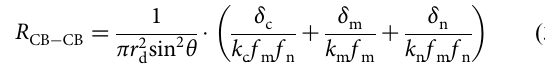
Fig. 5 Melting process of an ice droplet on the MCNP surface. a Schematic illustration of melting process. b Direct observation from the side view. The orange dashed line indicates the melting front. Blue curved arrow represents the inclining direction of the ice droplet. Red arrows indicate the bubble movement directions. Bubbles and air pockets are marked with orange dashed boxes and red dashed boxes, respectively. c Direct observation from the top view. The magni fi ed observation for the bottom air pockets is shown in the 4th picture. d Proof of bubbles downward movement and squeezing into the bottom micro-nano valleys sequentially. e Magni fi ed observations for the recovery of the bottom air pockets with the increase of temperature. A schematic of bubbles movement during the melting stage is depicted. f The changes of contact diameters and contact angles of droplets with the temperature increase. Three stages of the melting process are marked by black dashed lines, which are the warming stage, melting stage, and stabilizing stage, respectively. Temperatures, times and scale bars corresponding to different states are marked. The scale bars of b – d are 300 μ m, 300 μ m, and 100 μ m, respectively. The fl uctuations of the correlation evaluations can be found in the